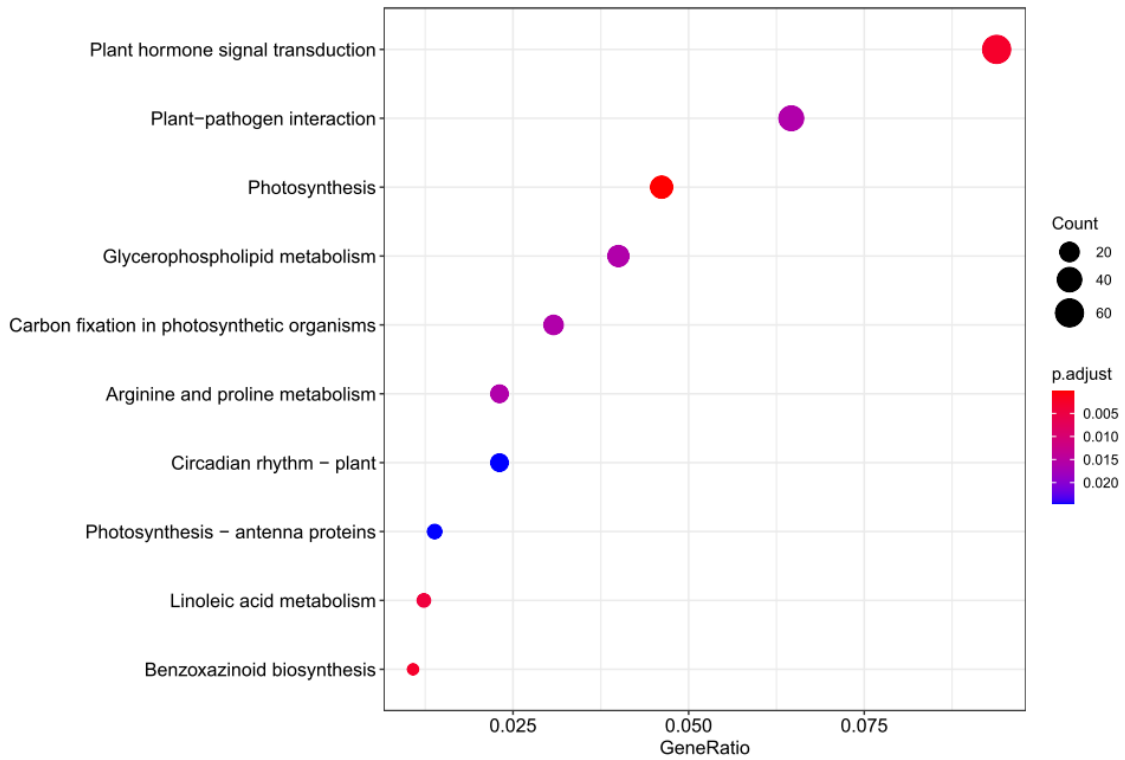
Figure 5. KEGG pathway enrichment analysis of DEGs.